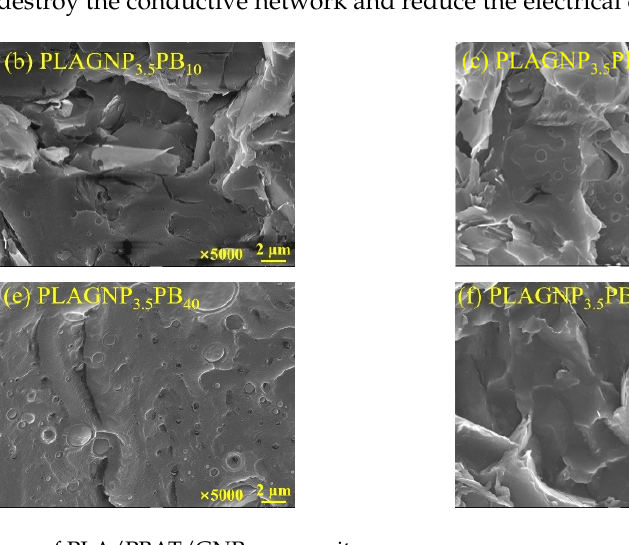
Figure 3. SEM images of PLA/PBAT/GNPs composites.